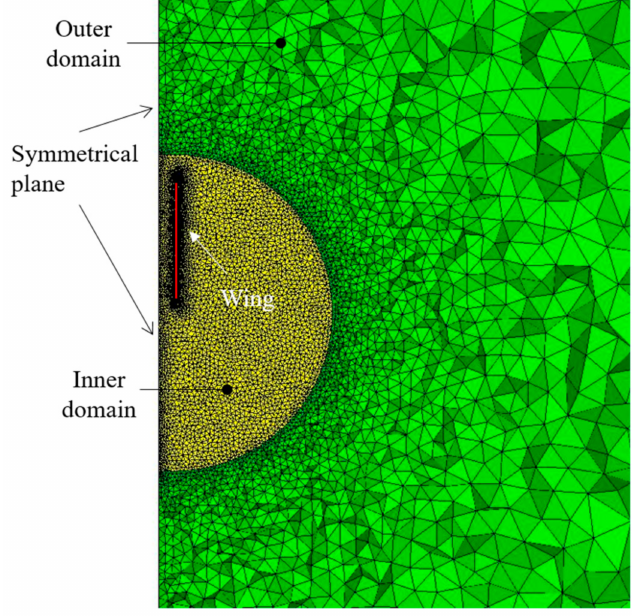
Figure 8. Cross section of the computational